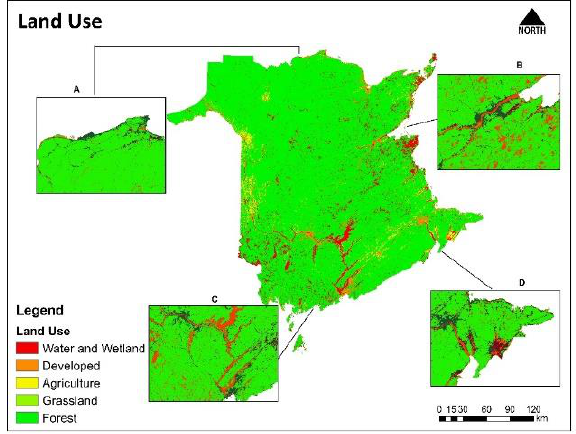
Figure A15. Population living In Rented Apartments.